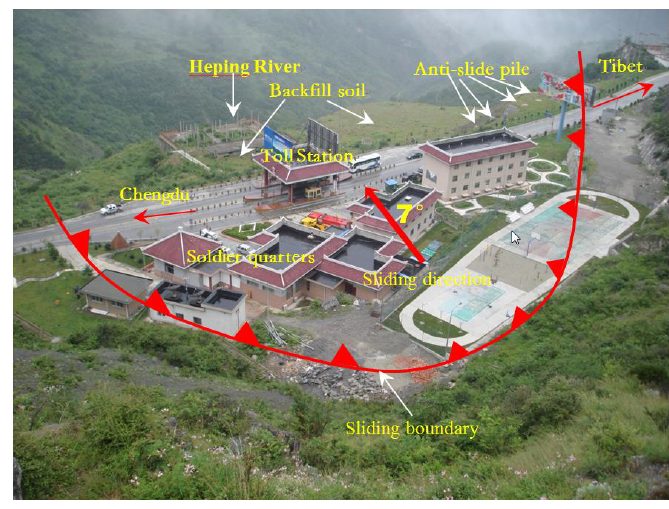
Figure 1. Zhenzilin landslide.